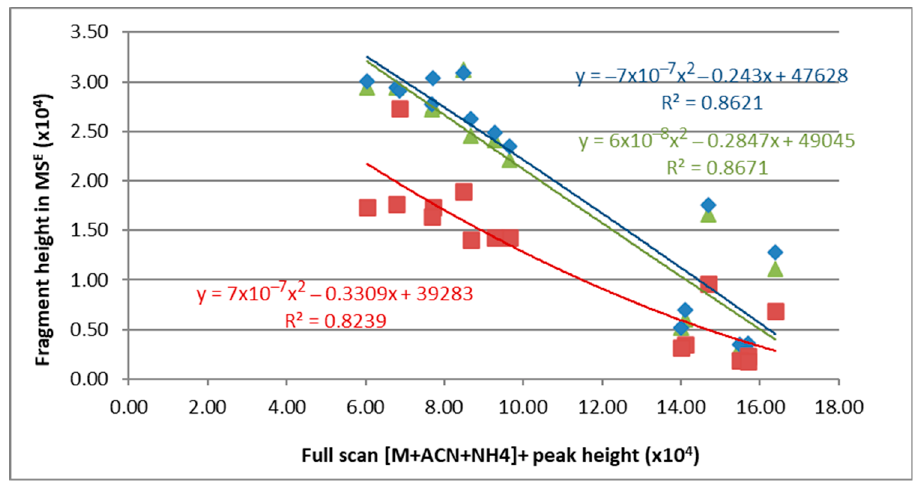
Figure 6. Correlation of the deshydroxydiacylglycerol (acyl in the Y-axes) peak heights in the MS E spectrum with the [M + NH 4 ] + ( a , b ) or the [M + ACN + NH 4 ] + ( c , d ) peak heights in the full scan. The peak intensities varied with the [NH 4 OH]. Results are shown for two triacylglycerols: ( a , c ) for TAG(17:0/18:1/17:0); blue diamonds, acyl in sn -1 and sn -3 positions (C17:0); red squares, acyl in sn -2 position (C18:1); ( b , d ) for TAG(14:0/18:1/22:0); blue diamonds, acyl in sn -1 position (C22:0); green triangles, acyl in sn -2 position (C18:1); red squares, acyl in sn -3 position (C14:0) Adscription of sn -1 and sn -3 positions is arbitrary. See Supplementary Information for other standards.